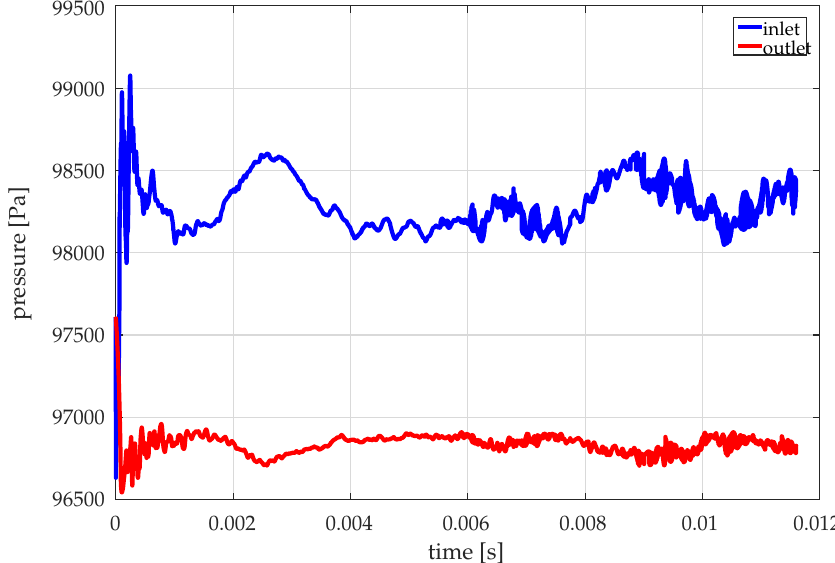
Figure 8. Average fluid pressure on the inlet Γ I and on the outlet Γ O . Figure 9 shows the displacement of the top of the vocal fold in horizontal ( u 1) and vertical ( u 2) directions. The numerical simulation of the VF vibrations started from zero initial conditions and static fluid forces deformed the VFs statically, predominantly in the horizontal direction. This effect shifted the mean value of VFs self-oscillations down- stream. The vibration amplitudes with frequency ca. 100 Hz in the horizontal direction are